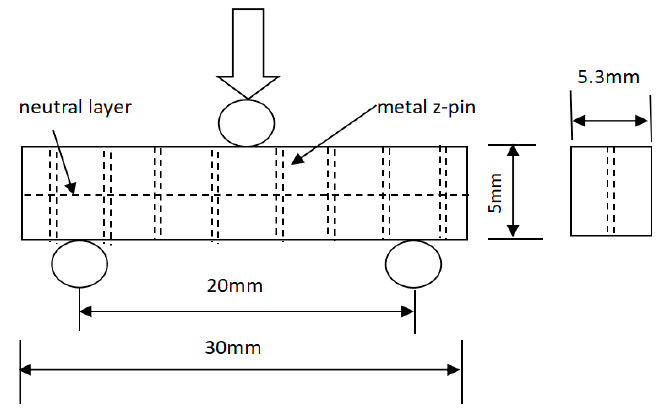
Figure 2. Schematic of short beam shear testing.